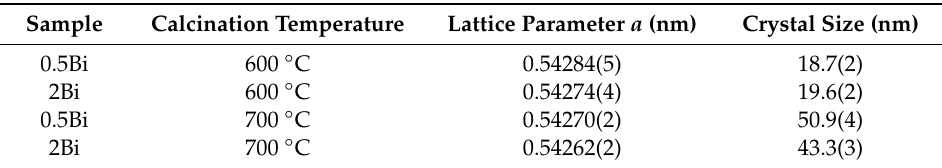
Table 2. Lattice parameter and crystal size of calcined